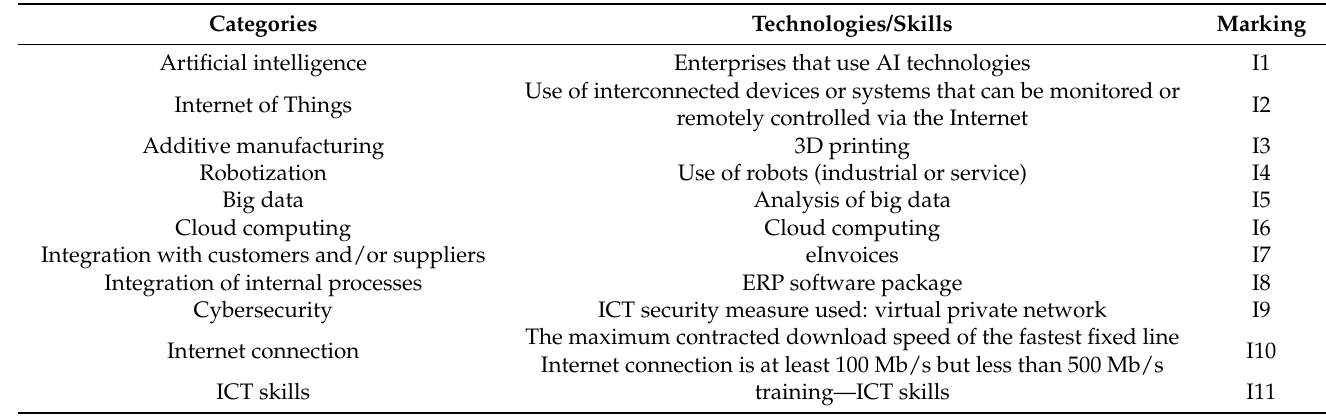
Table 3. Summary of indicators used to study the degree of digitalization of enterprises in the CEE